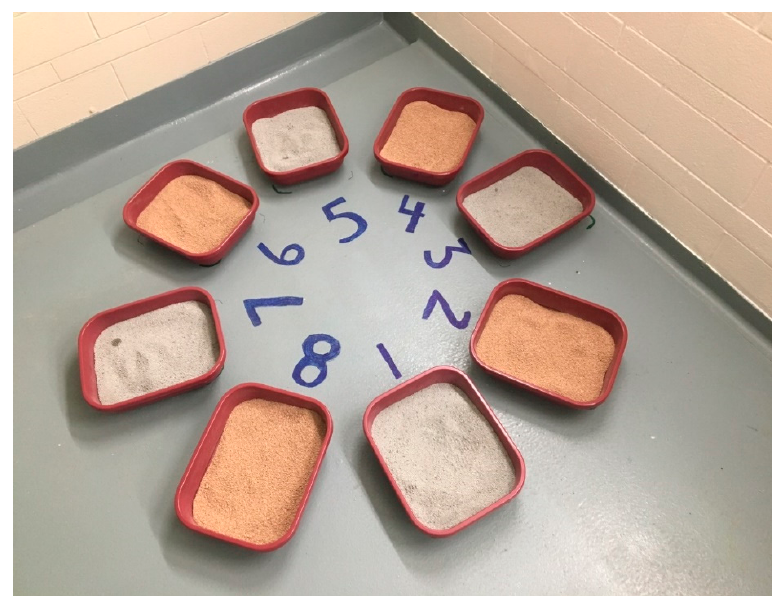
Figure 1. The circular arrangement of litter boxes at the start of the trial with Cohort 2 containing alternating clay and plant-based litter substrates.